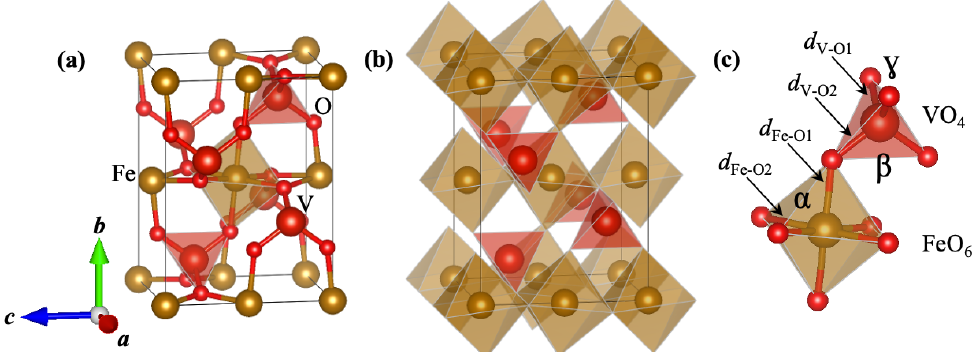
Figure 1. ( a ) Crystal structure of FeVO 4 - II polymporph, ( b ) polyhedral representation of the structure, and ( c ) irregular polyhedra of FeO 6 and VO 4 units. The different bond distances mentioned in the text are labeled as well as the bond angles. We used the VESTA software [46] to build the structures.